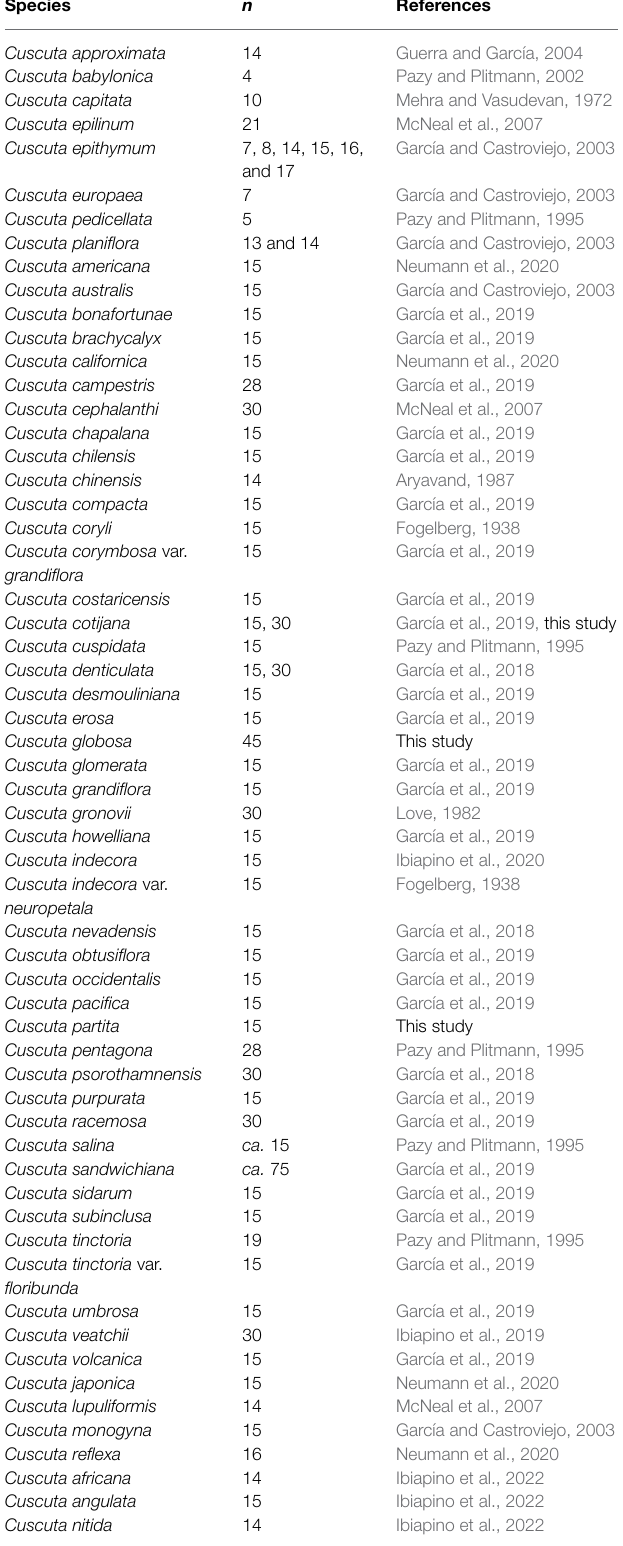
TABLE 2 | Haploid chromosome numbers ( n ) considered for character